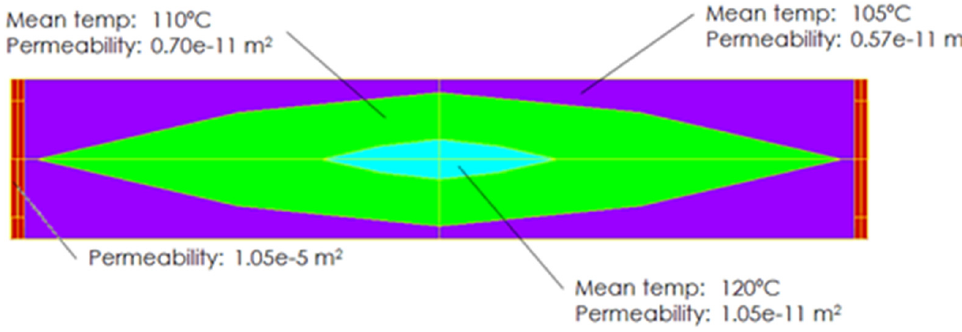
Figure 12. Permeability values contour. Table 4. Temperature-dependent real and simulation values for viscosity and permeability.